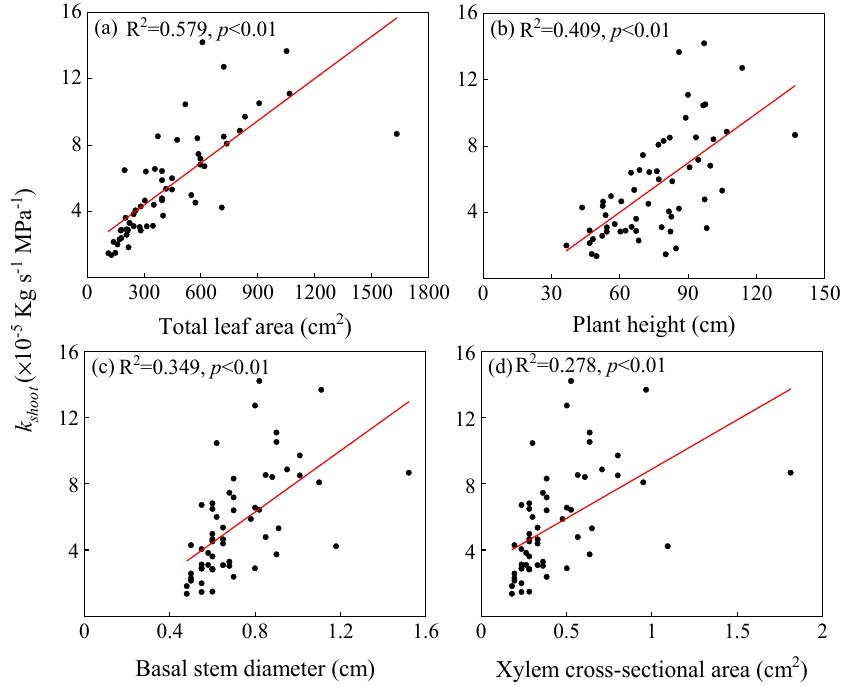
Figure 1. Regression relationships of whole-shoot hydraulic conductance ( k shoot ) and ecological variables: ( a ) total leaf area, ( b ) plant height, ( c ) basal stem diameter, and ( d ) xylem cross-sectional area. All regressions shown were statistically significant ( p < 0.01).